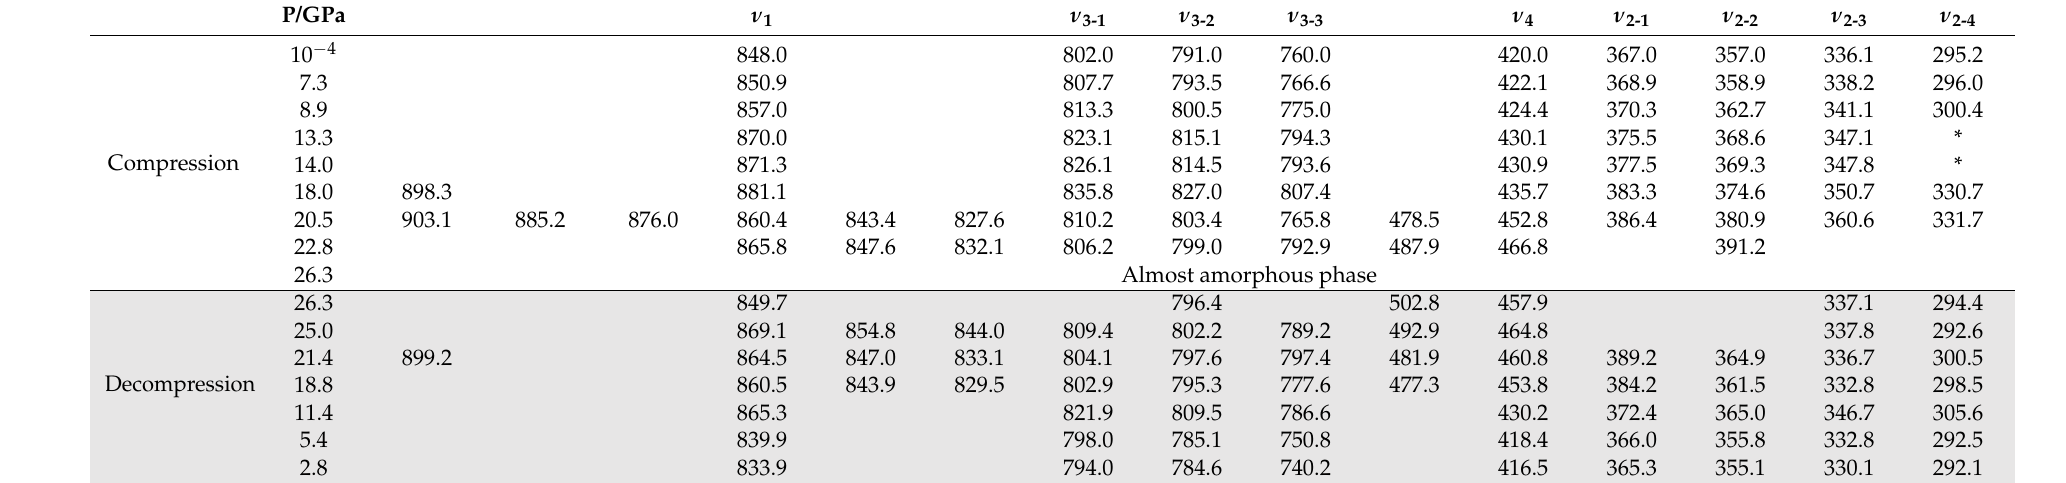
Table 1. Raman mode ν i wavenumbers (cm − 1 ) of vanadinite at various